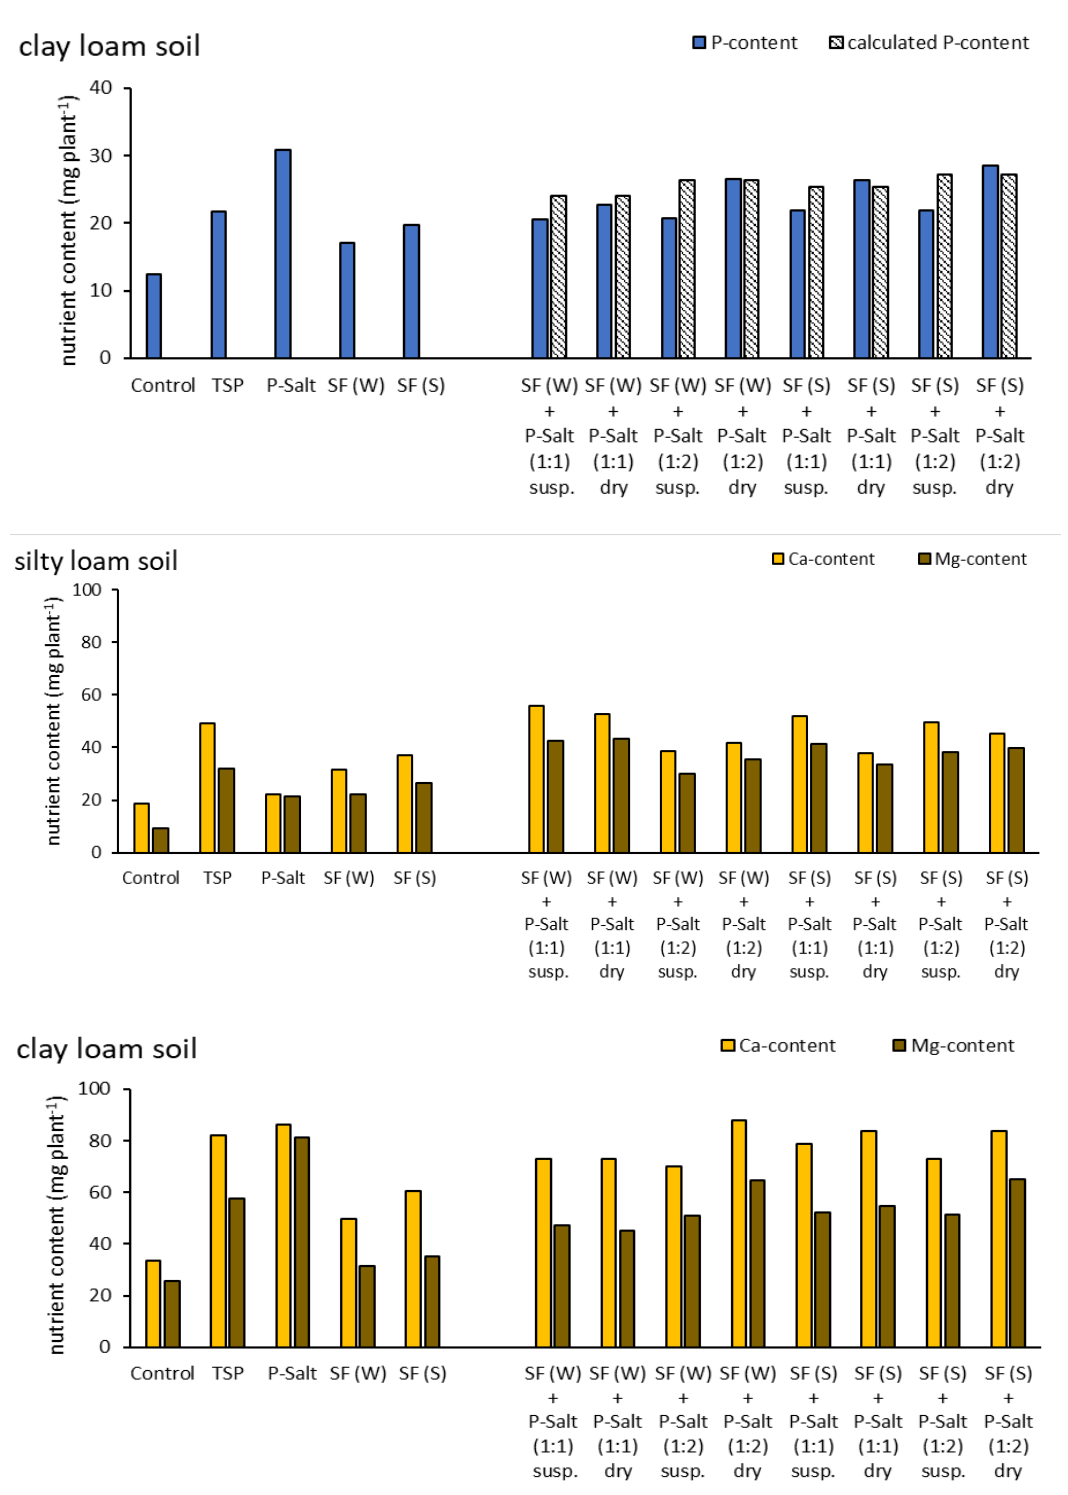
Figure 5. Total and calculated content per plant of P (P-content, calculated P content), and total content of Ca and Mg (Ca/Mg-content) in maize in mg/plant after soil treatment with different recycled digestate fertilizers in a total dose equivalent to 150 mg P (kg soil − 1 ). Please see Figure 3 for all other details. “Calculated P-content” represents a mathematical calculation of the combinations based on the results of the measured P-concentration of each single component (P-Salt, SF(W), SF(S)) to indicate possible additive effects (see material and methods: evaluation of synergistic effects, Equations (1) and (2)). Data are means of four replicates each.